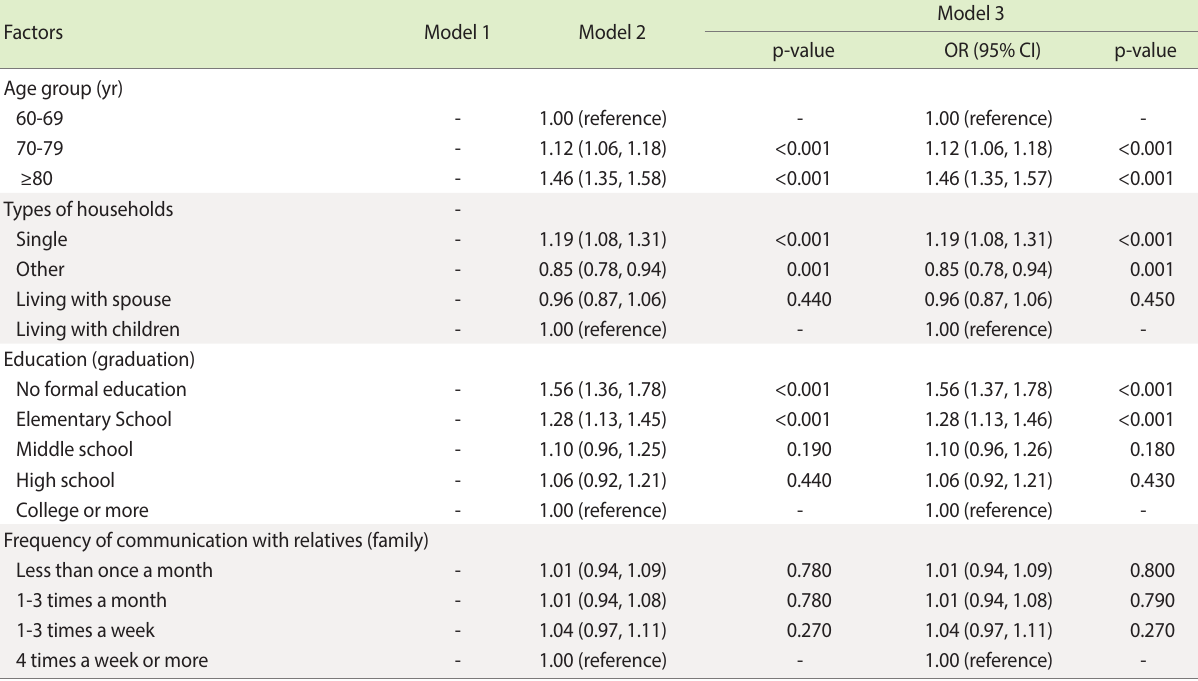
Table 3. Results of multilevel analysis of suicidal ideation considering both individual and community